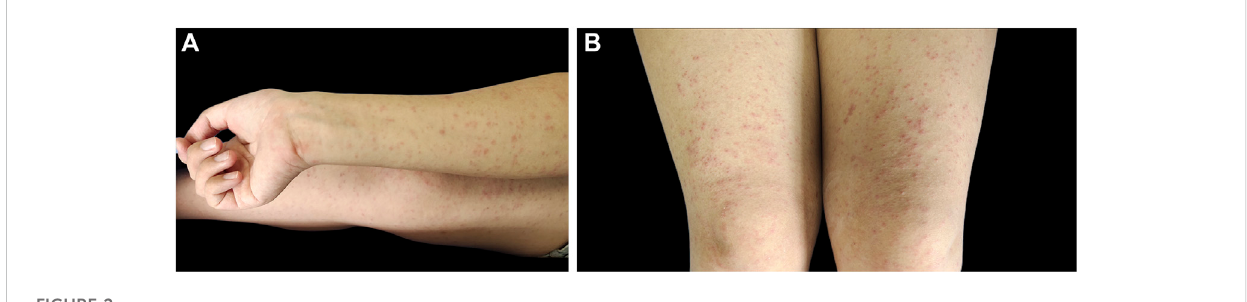
FIGURE 2 Papular rash on the right extremities (A) and both upper legs (B)